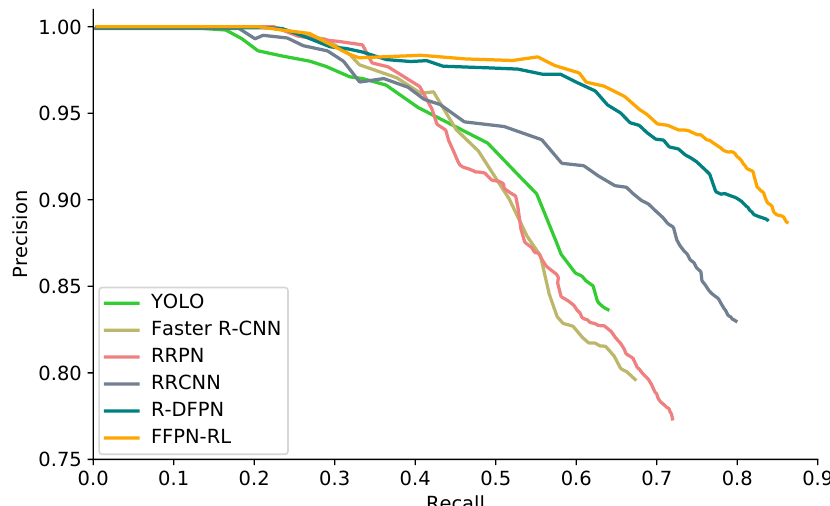
Figure 17. Precision–Recall curves of You Only Look Once Network (YOLO) [22], Faster Regions Convolution Neural Network (Faster R-CNN) [20], Rotation Region Proposal Networks (RRPN) [25], Rotational Region CNN (RRCNN) [26], Rotation Dense Feature Pyramid Networks (R-DFPN) [27] and FFPN-RL ship detection